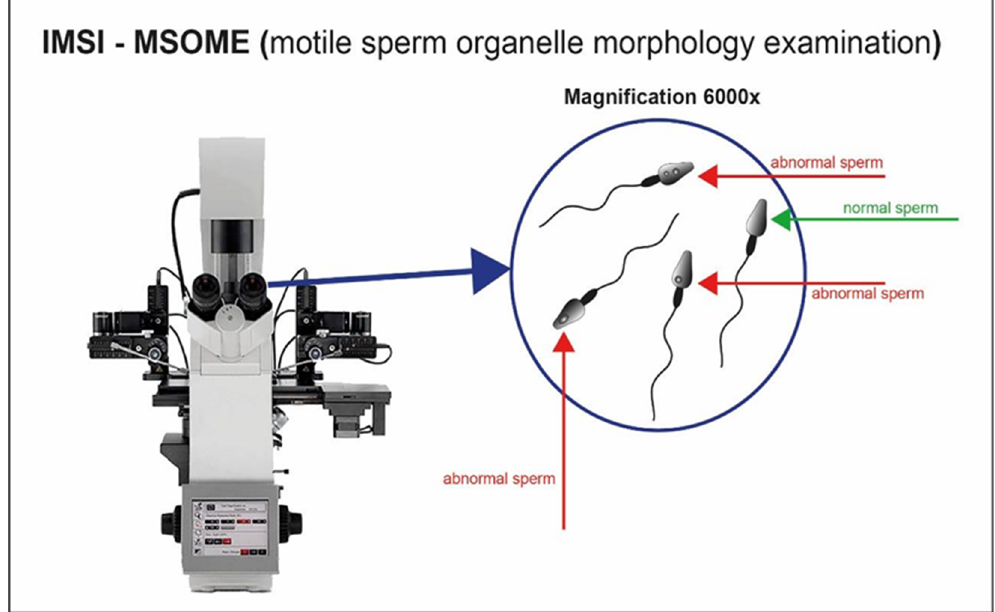
Figure 9. Sperm cell visualization with magnification system 6000×. Sperm cells with appropriate morphology are well selected through the high magnification.